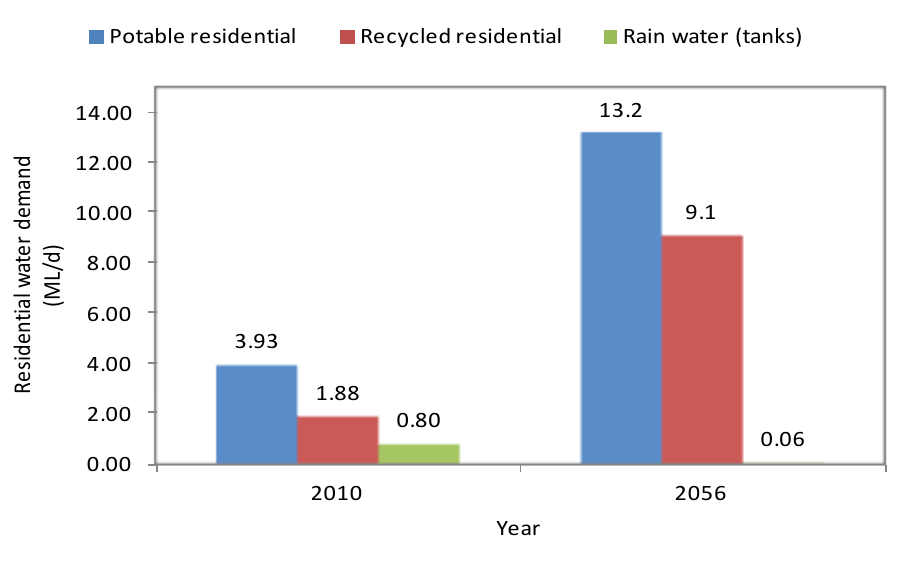
Figure 2. Residential base case water demand forecast for proposed